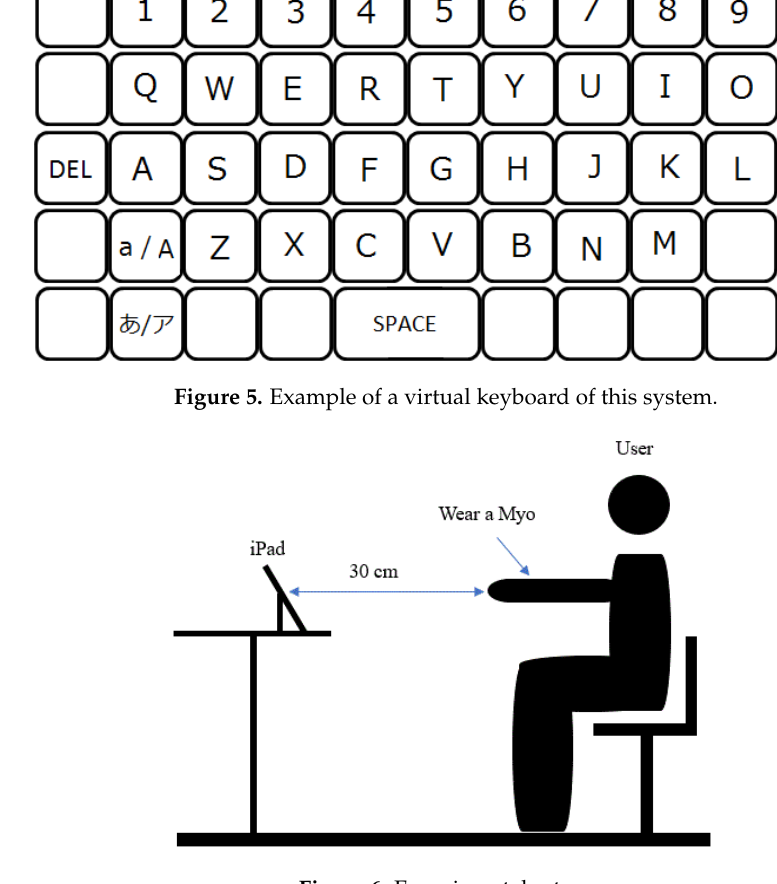
Figure 6. Experimental